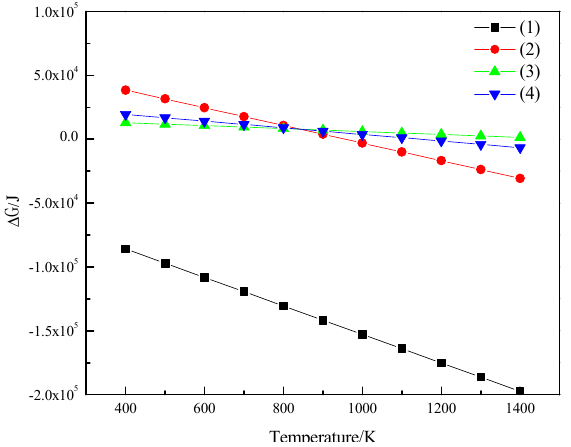
Figure 4. Gibbs free energy of H 2 reduction of iron